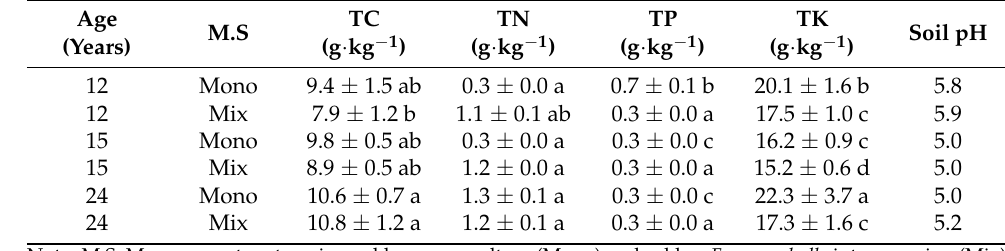
Table 4. Basic characteristics of